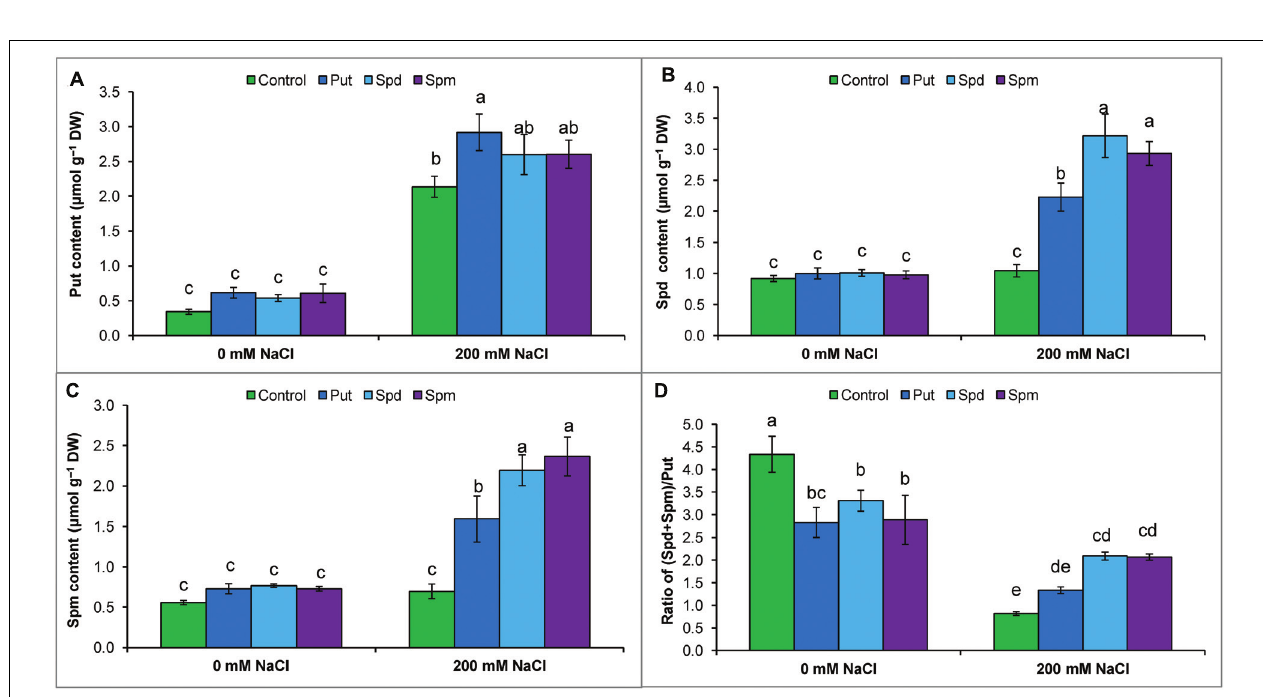
FIGURE 4 | Effect of exogenous polyamines on glyoxalase enzymes and in reducing MG toxicity in mung bean seedlings subjected to salt (NaCl, 200 mM) stress. Activity of Gly I (A) , activity of Gly II (B) , and MG content (C) . Here, Put, Spd, and Spm indicate putrescine (0.2 mM), spermidine (0.2 mM), and spermine (0.2 mM), respectively. Mean ( ± SD) was calculated from three replicates for each treatment. Bars with different letters are significantly different at P ≤ 0.05 applying Tukey’s HSD test.